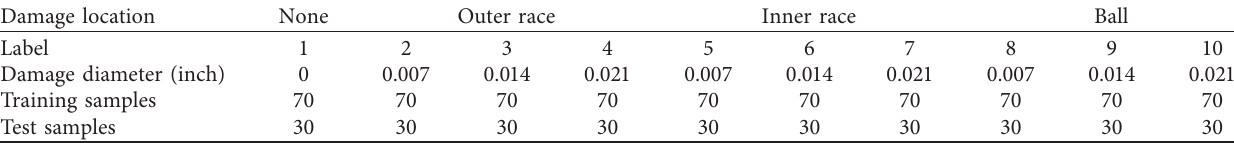
Table 1: The detailed information of the dataset.